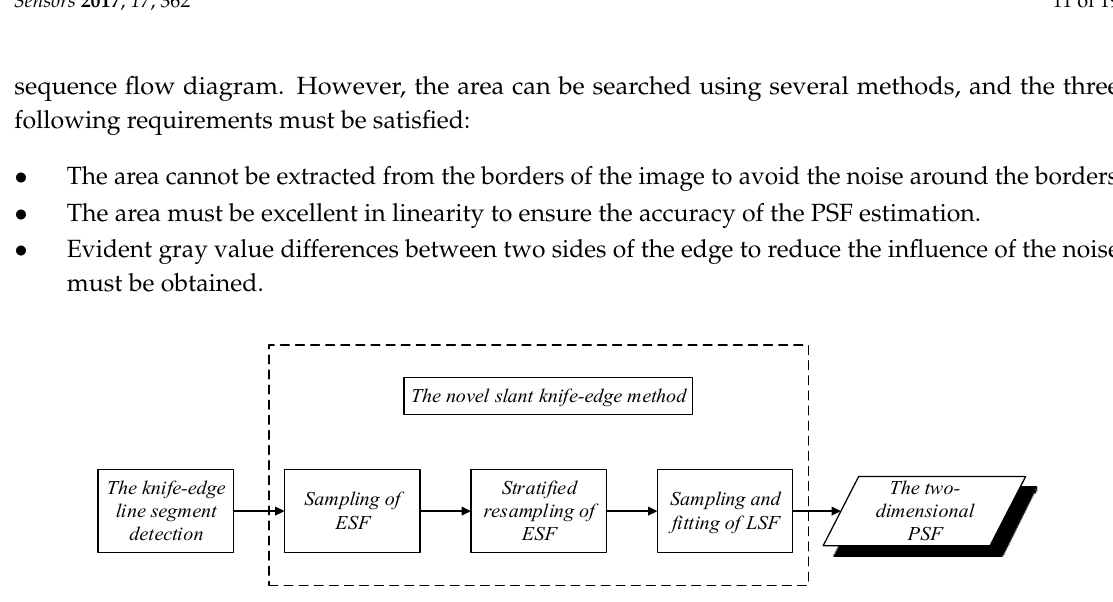
Figure 7. Process of the novel slant knife-edge method in a simplified sequence flow diagram. The original data and results of the experiment are displayed in Figure 8. The measurement area and three examples of extracted knife-edge areas are also shown. Most of the knife-edge areas extracted successfully and the process of removing the weak-related areas are displayed. Follow ups are described in detail. ESF sampling, ESF denoising, ESF resampling, and LSF sampling results are shown in Figure 9.